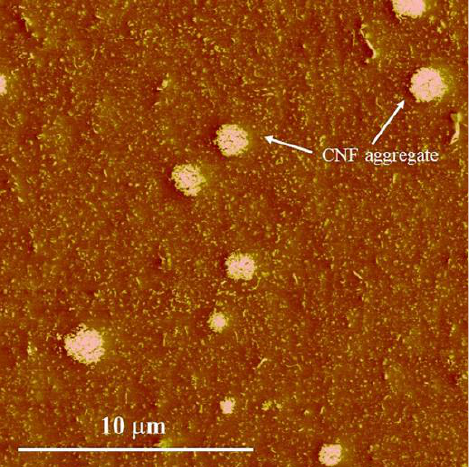
Figure 3. AFM image of CNF/NR observed across large area ( 20 μm 2 ).